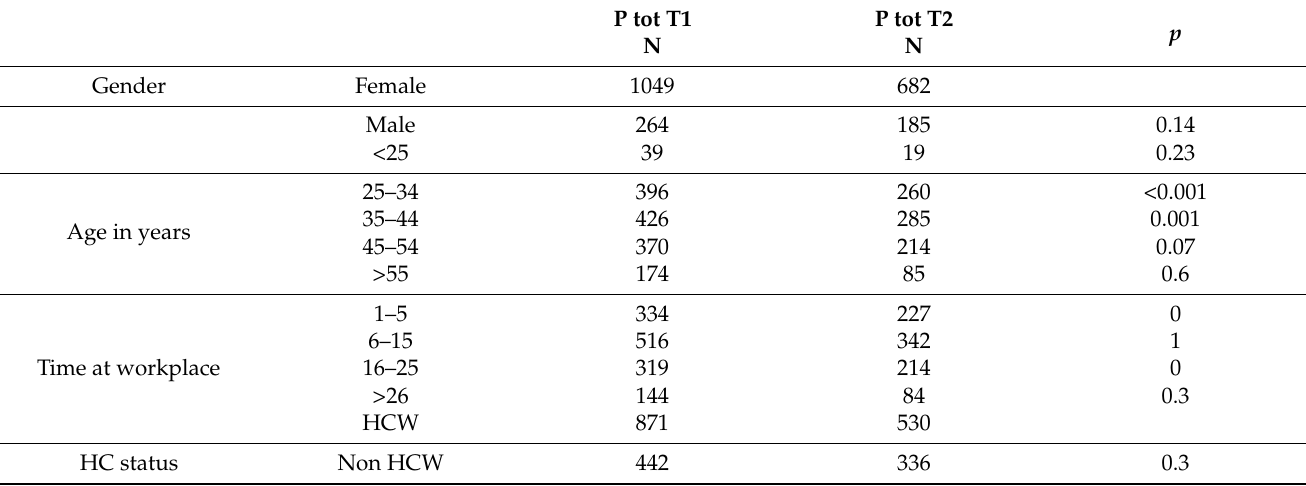
Table 2. Comparison between populations included at T1 and